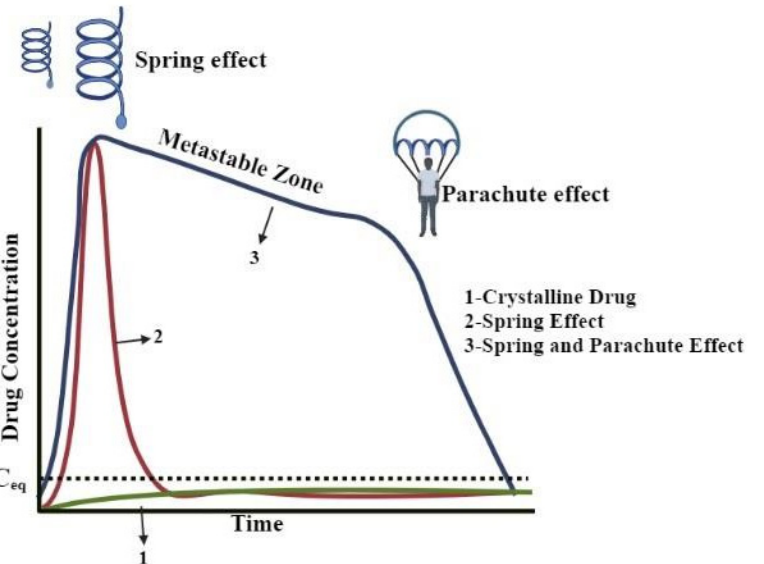
Figure 4. To generate higher apparent solubility for aqueous insoluble drugs, the spring and para- chute idea was used. parachute idea was